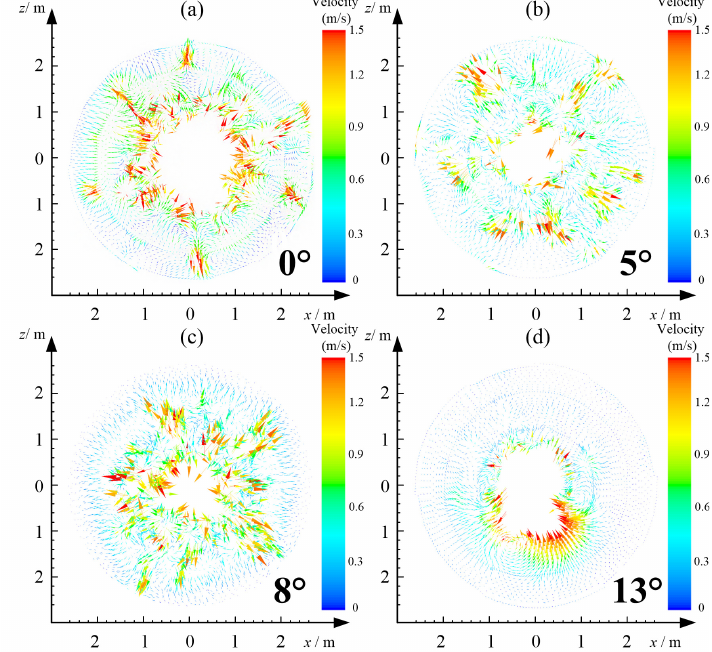
Figure 10. Velocity vector of molten steel at the liquid level with different multi-nozzle oxygen lances. ( a ) NTA = 0 ◦ ( b ) NTA = 5 ◦ ( c ) NTA = 8 ◦ ( d ) NTA = 13 ◦